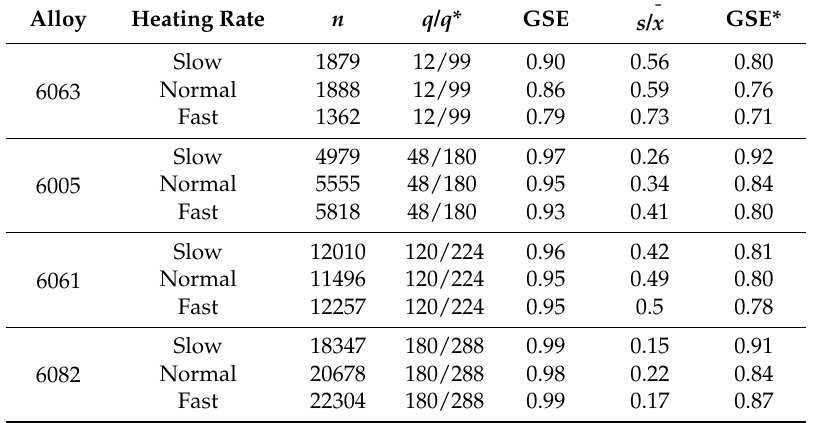
Table 3. The results from the GSE analysis where GSE refers to Equation (2) and GSE* refers to Equation (3).